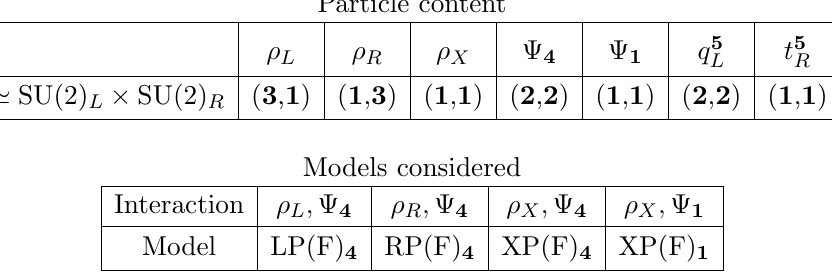
, and it is embedded in an R , R